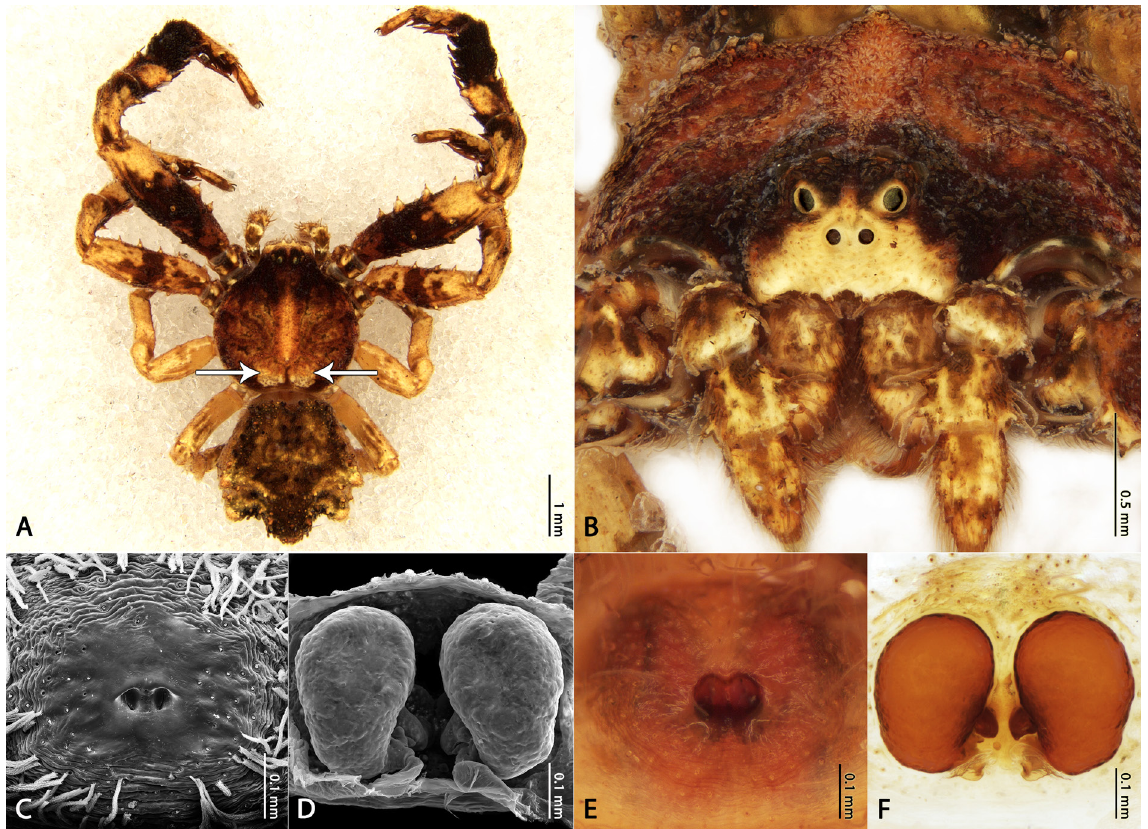
Fig. 7. Female of Kryptochroma parahybana (Mello-Leitão, 1929) gen. et comb. nov. (MPEG 30339) A . Habitus, dorsal view (arrows indicate the pair of circular taints on the posterior slope of the prosoma). B . Front. C, E . Epigynal plate, ventral view. D, F . Spermathecae, dorsal